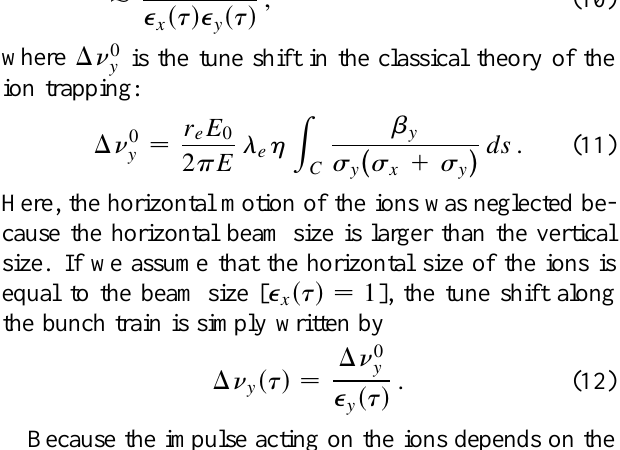
FIG. 9. (Color) The change of the tunes along the 280 bunch train. Blue circles and a red curve correspond to the experimen- tal results and the theoretical values,